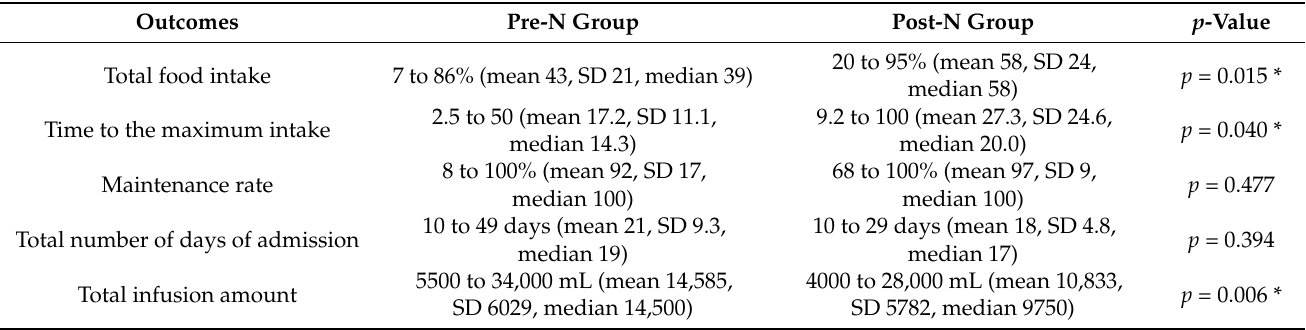
Table 2. Total food intake, time to maximum intake, maintenance rate, total number of days of admission, and required amount of intravenous